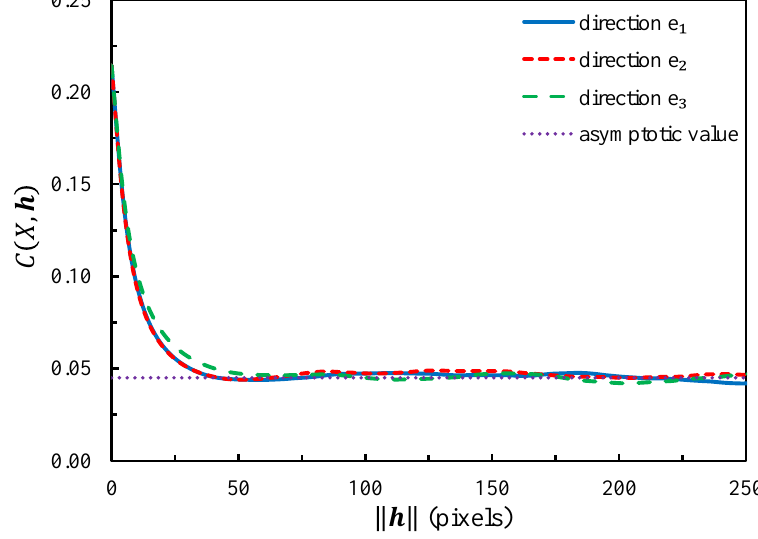
Figure 2. Covariance functions in three directions of the solid phase of closed-cell sample